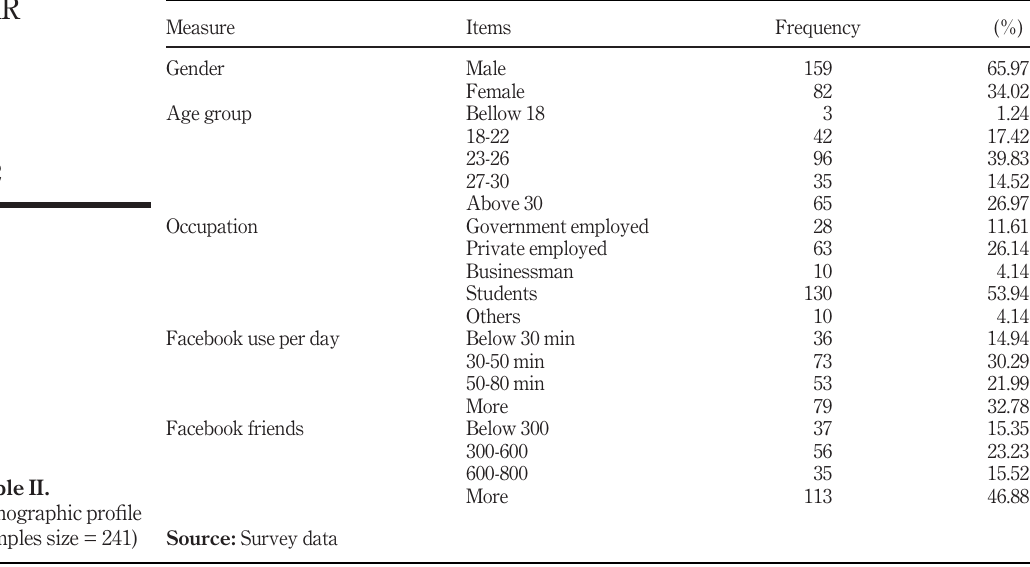
Table II. Demographic pro fi le (samples size = 241)